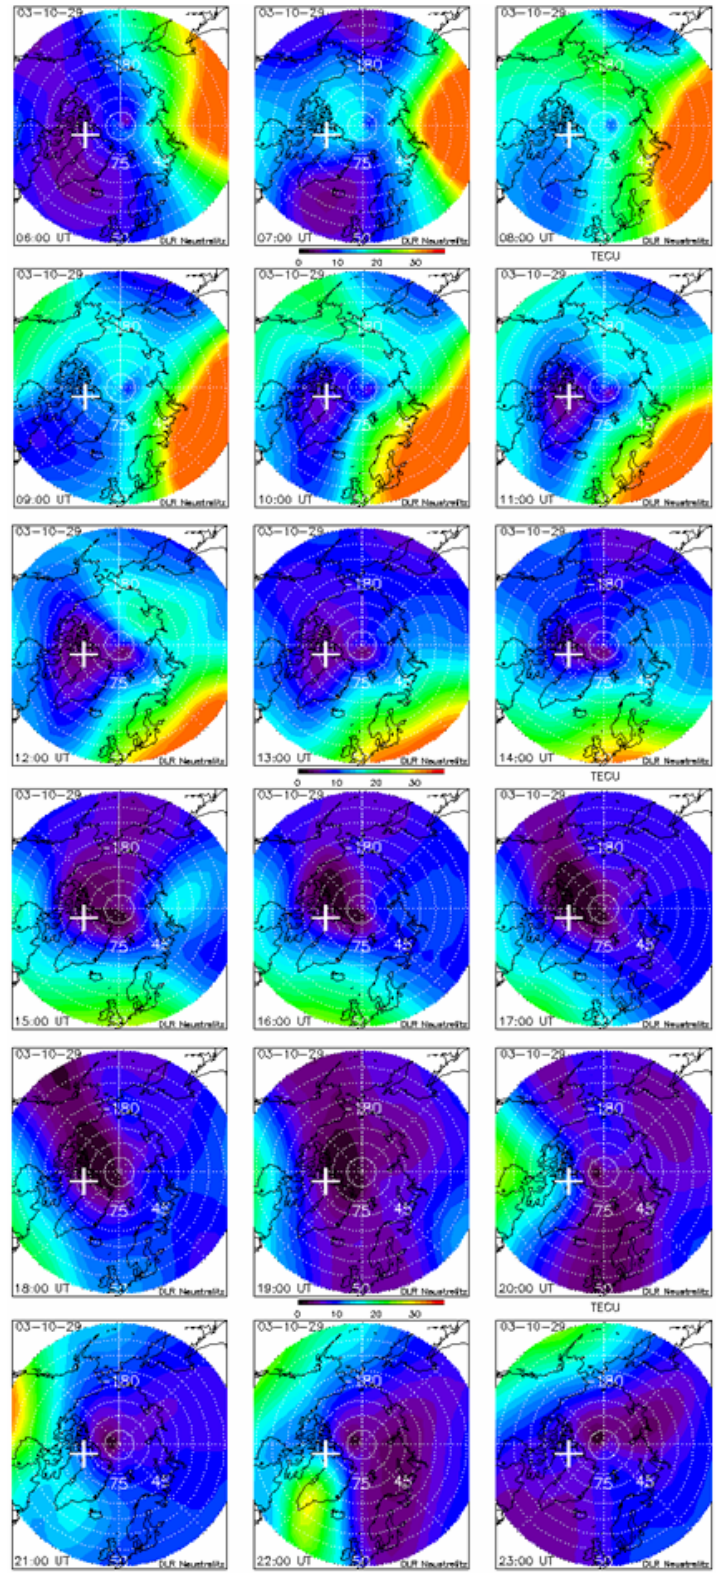
Fig. 3. Ground-based GPS TEC observations over the North Pole region in the 06:00 UT–23:00 UT period on 29 October